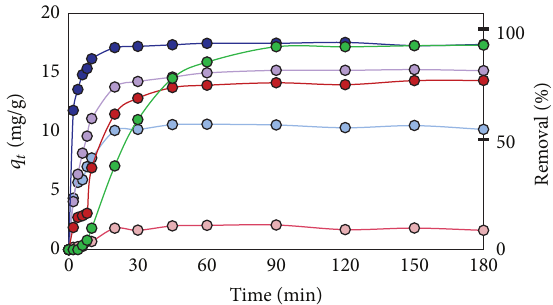
Figure 8: Plot of Pb 2+ adsorption capacity at time ( 𝑞 𝑡 ) and % removal versus adsorption time for effect of various sorbents (RS (light blue), RS-oil 3hr (purple), RS-NaOH 450 W (blue), Bagasse (pink), Bagasse-NaOH 600 W (red), and Dowax